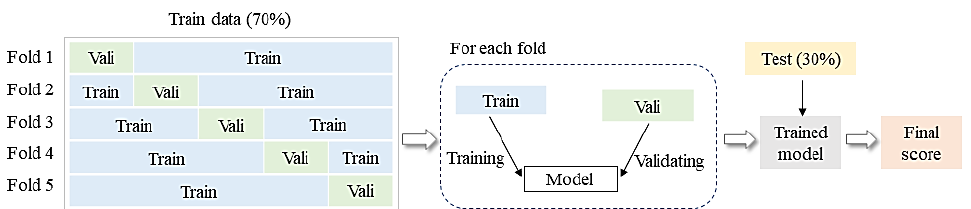
Figure 4. Workflow of the classification method. Vali in each fold of train data means validation data. The classification model is trained on the Train of each fold and is validated on Vali. After training on each fold, the parameter of the trained model is saved and used as the initial parameter of the classification model of next fold. The final trained model is evaluated using Test (30%).